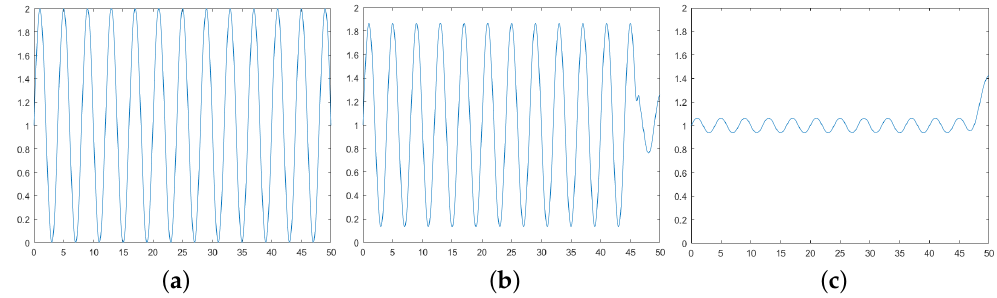
Figure 1. Comparison results: ( a ) Original signal. ( b ) Result of telegraph diffusion-based model. ( c ) Result of non-telegraph diffusion-based